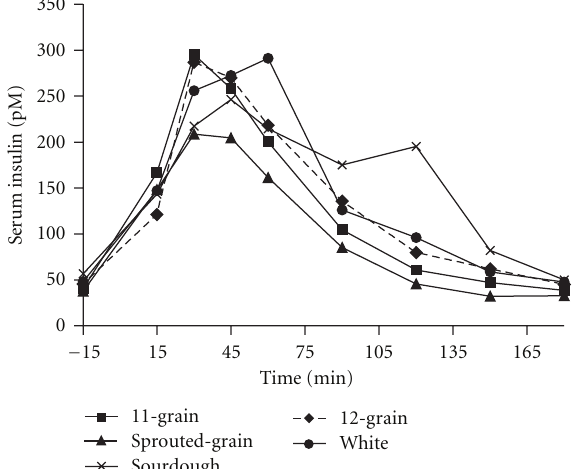
Figure 3: Fasting and postprandial GLP-1 responses to the inges- tion of 50 g available carbohydrate of the test breads. Data are means. Standard errors are not included for clarity, n = 11. Test bread was ingested after collection of fasting blood sample at time point − 15 min. Significant overall treatment e ff ects were found (sourdough bread was lower than 11-grain ( P < 0 . 0001), sprouted- grain ( P < 0 . 0001), and white ( P < 0 . 02) breads. 11-grain bread was greater than 12-grain ( P < 0 . 03) and white ( P < 0 . 03) breads. Sprouted-grain bread was greater than 12-grain ( P < 0 . 009) and white ( P < 0 . 05) breads).